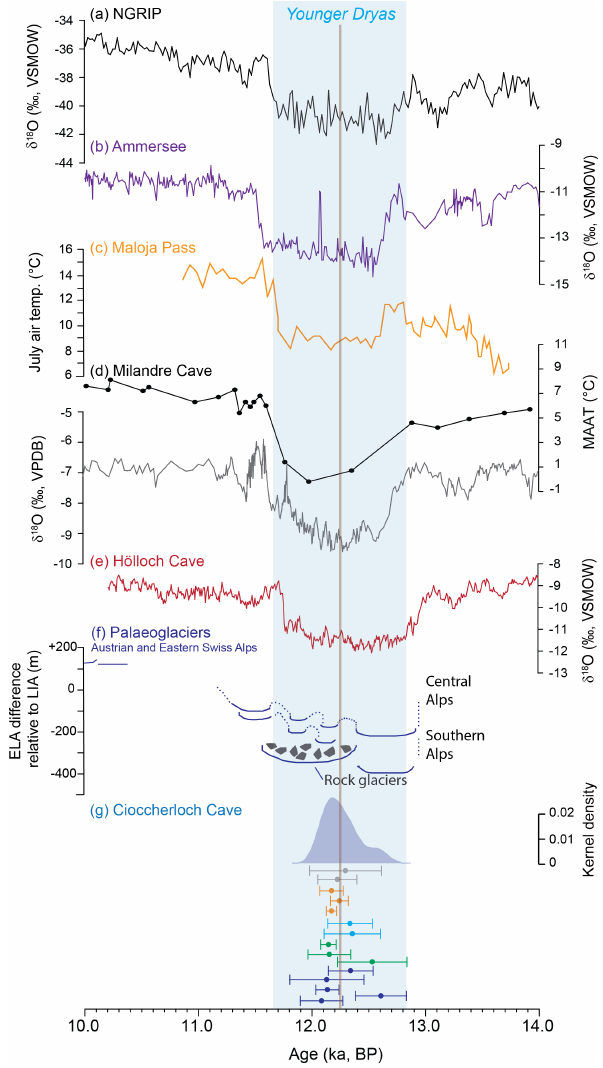
Figure 6. CCC ages from Cioccherloch (g) compared to YD proxy records in Europe and Greenland plotted on their published chronol- ogy. (a) NGRIP δ 18 O data (Rasmussen et al., 2014) and (b) lacus- trine benthic ostracod δ 18 O data from Ammersee (von Grafenstein et al., 1999). YD palaeotemperature reconstructions are shown by (c) chironomid-inferred July air temperatures from the Maloja Pass (Ilyashuk et al., 2009) and by (d) MAAT inferred from fluid inclu- sion stable isotope data on stalagmites and speleothem δ 18 O data from Milandre Cave (Affolter et al., 2019). CCC ages are compared to (e) speleothem δ 18 O data from Hölloch Cave (Li et al., 2021) and (f) the extent of central and southern Alpine palaeoglaciers (Heiri et al., 2014b). The calculated kernel density of all 230 Th ages is shown by the blue shaded area (g) . Dark blue and green refer to 230 Th ages of CCCs from heap A and B, respectively (f) . Data from heaps C, D and E are shown in light blue, orange and grey, respectively (g) . The brown vertical line marks the mid-YD transition recorded at Meerfelder Maar (Lane et al.,